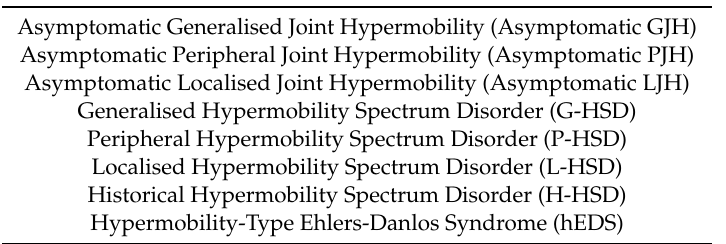
Table 1. Spectrum of joint hypermobility phenotypes. Adapted from Castori et al., 2017 [15]. Asymptomatic Generalised Joint Hypermobility (Asymptomatic GJH) Asymptomatic Peripheral Joint Hypermobility (Asymptomatic PJH) Asymptomatic Localised Joint Hypermobility (Asymptomatic LJH) Generalised Hypermobility Spectrum Disorder (G-HSD) Peripheral Hypermobility Spectrum Disorder (P-HSD) Localised Hypermobility Spectrum Disorder (L-HSD) Historical Hypermobility Spectrum Disorder (H-HSD) Hypermobility-Type Ehlers-Danlos Syndrome (hEDS)